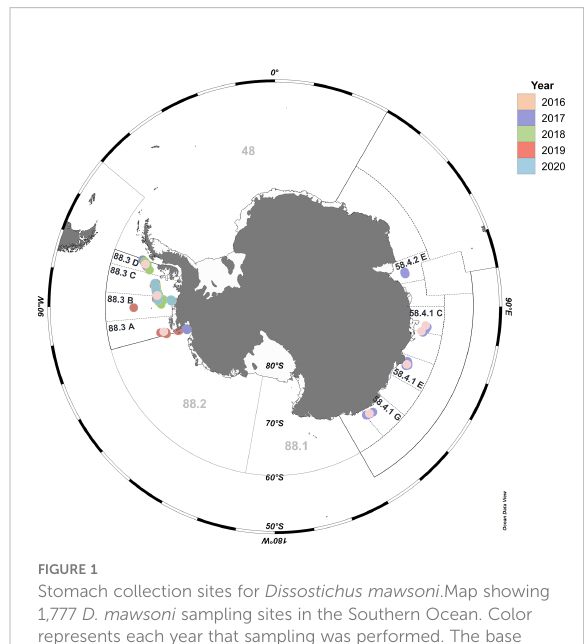
FIGURE 1 Stomach collection sites for Dissostichus mawsoni .Map showing 1,777 D. mawsoni sampling sites in the Southern Ocean. Color represents each year that sampling was performed. The base